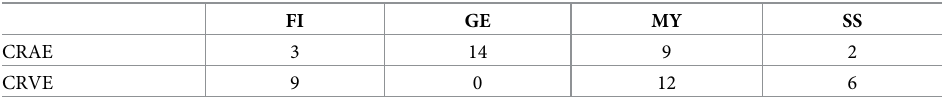
Table 7. Number of optic disc parameters significantly correlated with the CRAE or